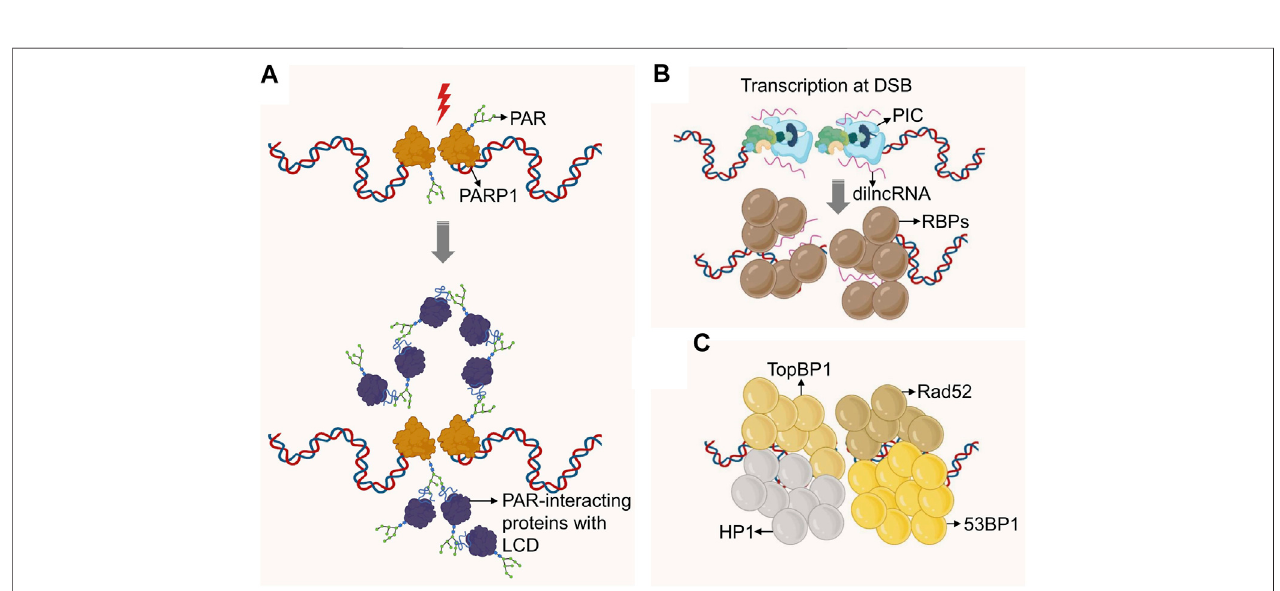
FIGURE 2 | Formation of DNA repair domains via phase separation. (A) DSBs recruit PARP1, which mediates DSB-proximal PARylation, attracting PAR-binding proteins, many of which contain Low Complexity Domains (LCD). The latter promote molecular crowding and concomitant phase separation. (B) DSBs recruit RNA Polymerase II, which initiates transcription at the DSB site to generate dilncRNAs. These RNAs are bound by IDR-containing RNA binding proteins (RBPs) which can drivephase separation. (C) Protein modi fi cations at DSBs recruit proteins such as53BP1, TopBP1, Rad52 and HP1, all ofwhich wereshown to form higher order condensates via phase separation. Ifthese domains are distinct or can befused remains to bedetermined. 53BP1 may further promote phase separation viaits binding to dilncRNA.